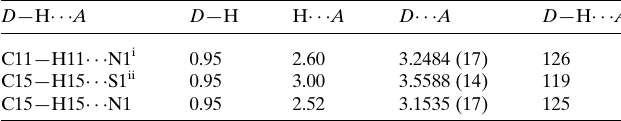
Table 3 Hydrogen-bond geometry (A˚ , (cid:2) ) for 1 .